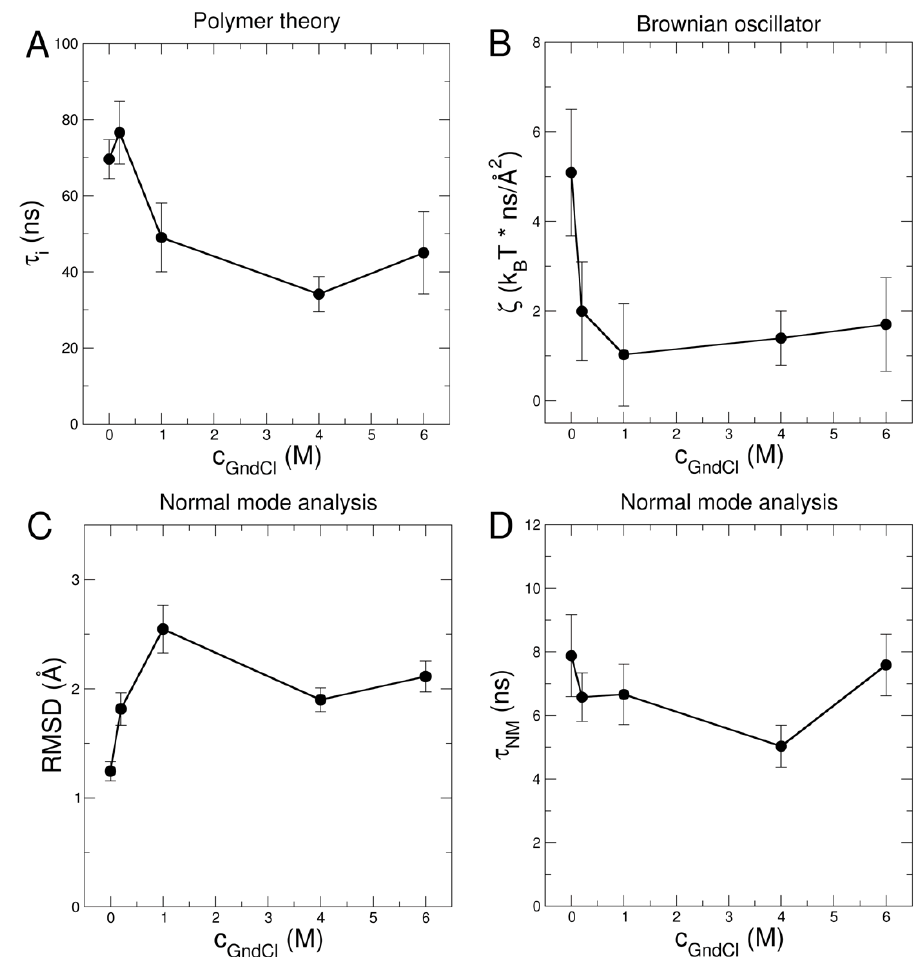
Figure 6. ( A ) Relaxation time of internal friction τ i obtained from the ZIF polymer model and ( B ) friction ζ as determined within the model of the Brownian oscillator. ( C ) RMSD per atom and ( D ) relaxation times of internal modes as function of GndCl concentration as determined by using NM analysis of the NSE